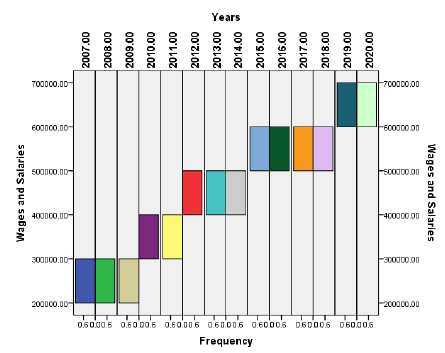
Figure 8. Wages and salaries Figure 9. Total of public